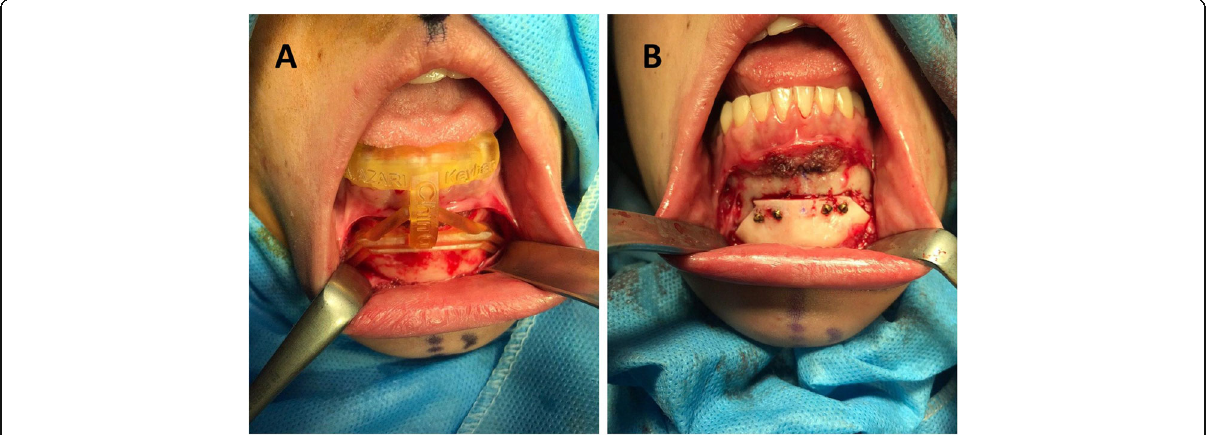
Fig. 3 a Application of a chin osteotomy surgical guide in a patient with a mild deviation of the chin. b Fixation of the chin in the corrected position using 4 titanium